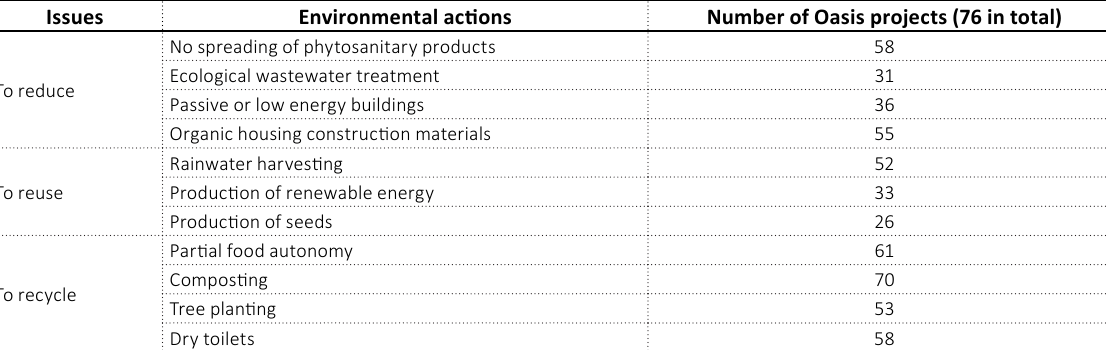
Table 2. Environmental actions undertaken by the Oasis projects